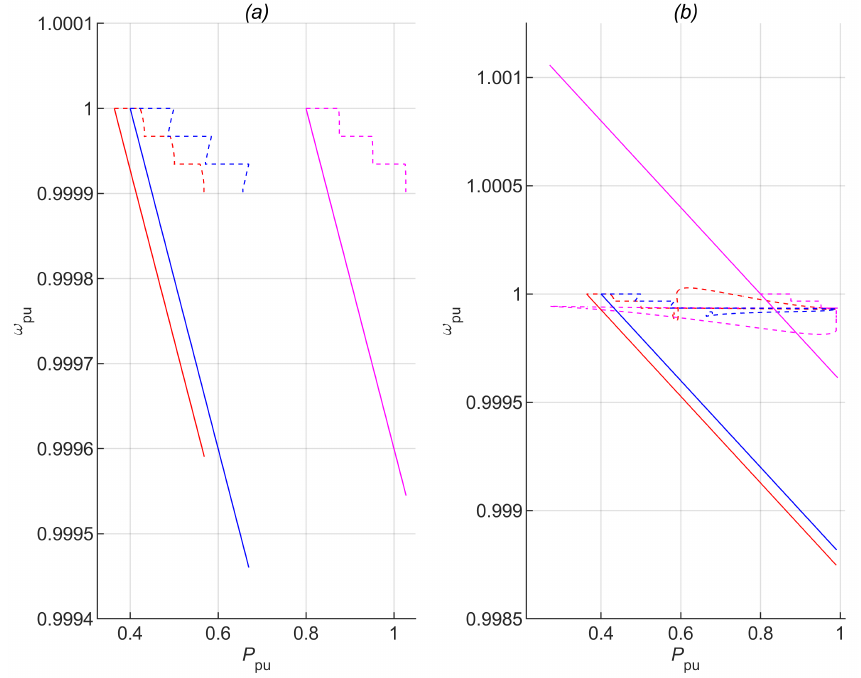
Figure 7. P − ω Droop Relation ( a ) no Jacobian, PFT, ( b ) with Jacobian, PFT; for VSIs at Buses (1—red, 2—magenta,